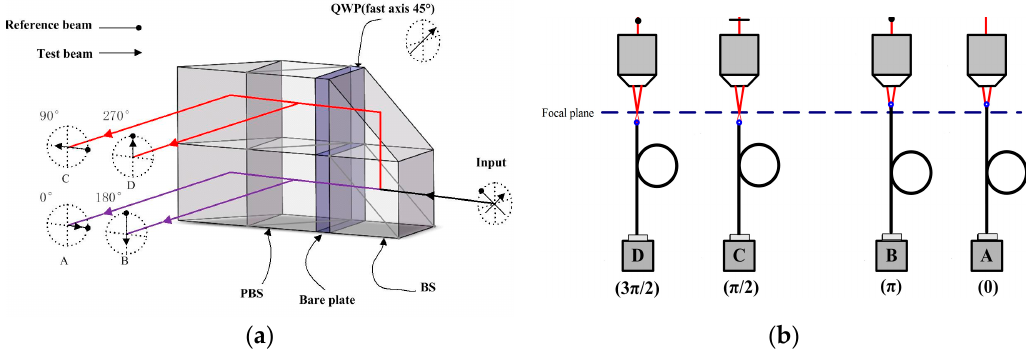
Figure 2. New single-body four-step phase-shifter for simultaneous phase-demodulation. ( a ) single body spatial phase shifter; ( b ) detectors with differential confocal microscopy.